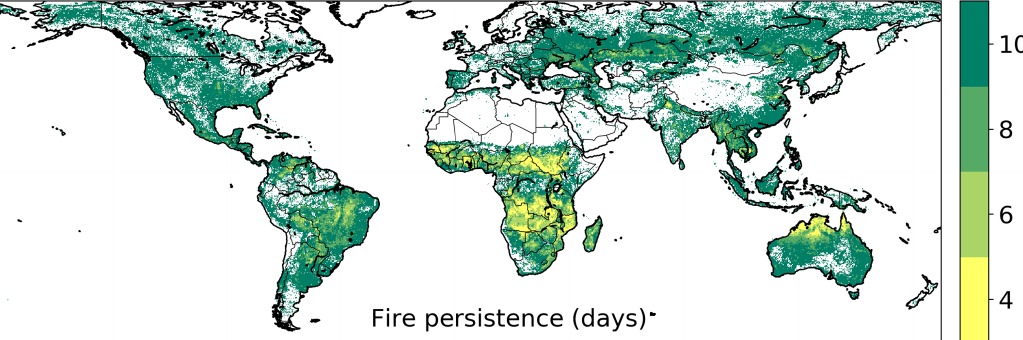
Figure A3. Average fire persistence threshold at 0.25 ◦ resolution. The fire persistence threshold determines how long a fire may take to spread from one 500m grid cell into the next. We used a 4d fire persistence threshold for 500m grid cells that burned more than three times during the study period (2003–2016), and a 6, 8 and 10d fire persistence period for grid cells that burned three times, twice or once,